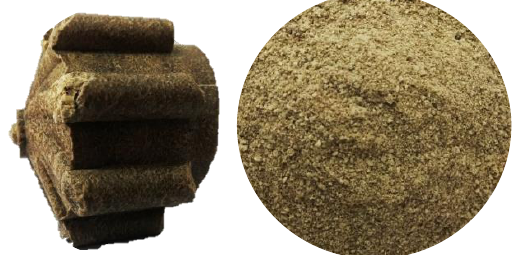
Figure 1. Green-coffee by-product before and after grinding.